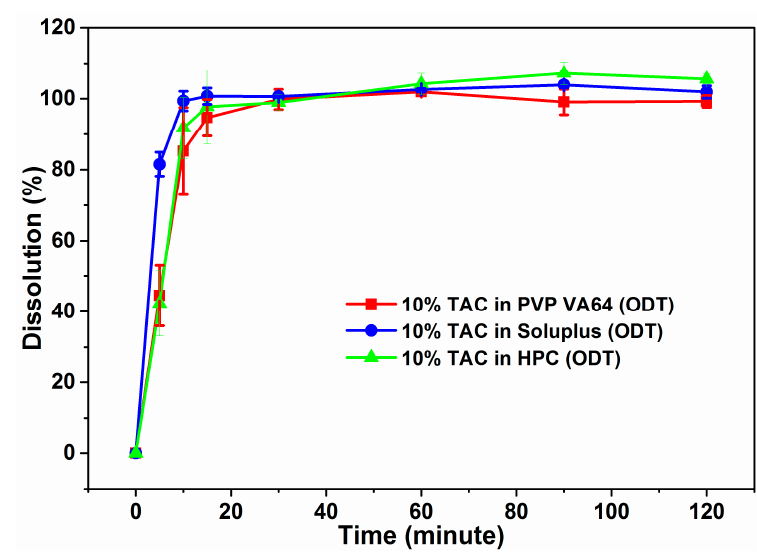
Figure 9. Dissolution profiles of ODTs containing solid dispersions of TAC.